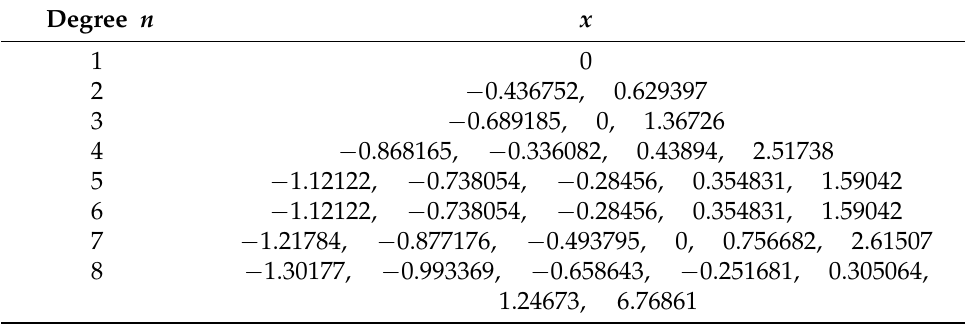
Table 2. Approximate solutions of H n , q ( x ) = 0, x ∈ R